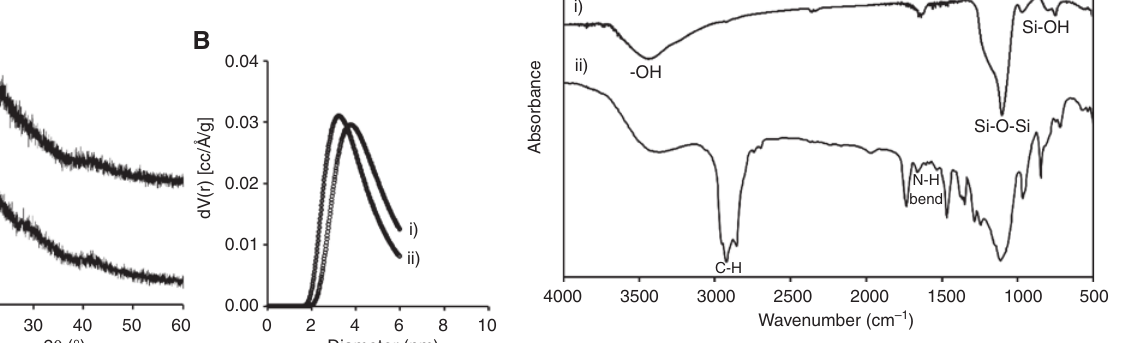
Figure 4: Fourier transform infrared (FT-IR) spectra of porous nano- silica (PNS) (i) and adamantylamine-polyethylene glycol-functioned cyclodextrin-porous nanosilica (PNSC@APEG)